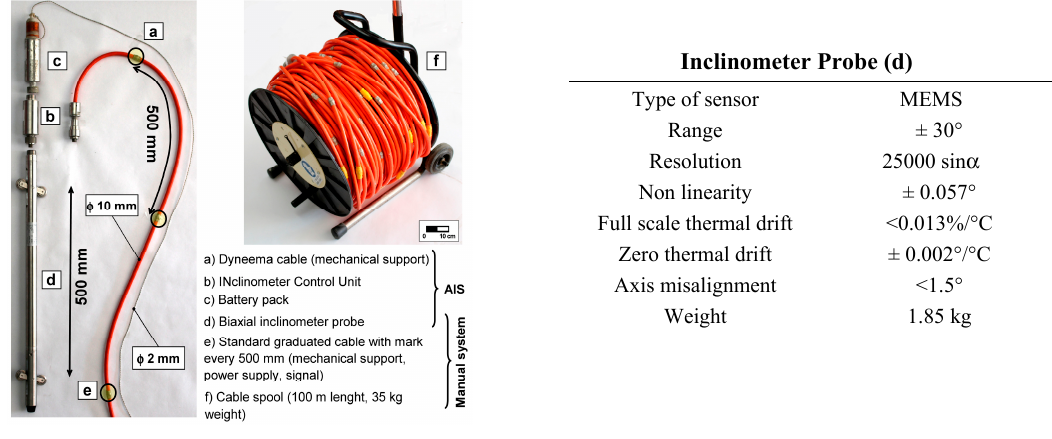
Figure 3. Comparison between the portable system (produced by the OTR Company, Piacenza, Italy) and AIS. In the more recent portable equipment, due to use of new digital probe, the diameter of graduated cable ( e , f ) was reduced to about 5 mm with 15 kg weight (for 100 m length). The probe used on AIS is the same of the portable system.